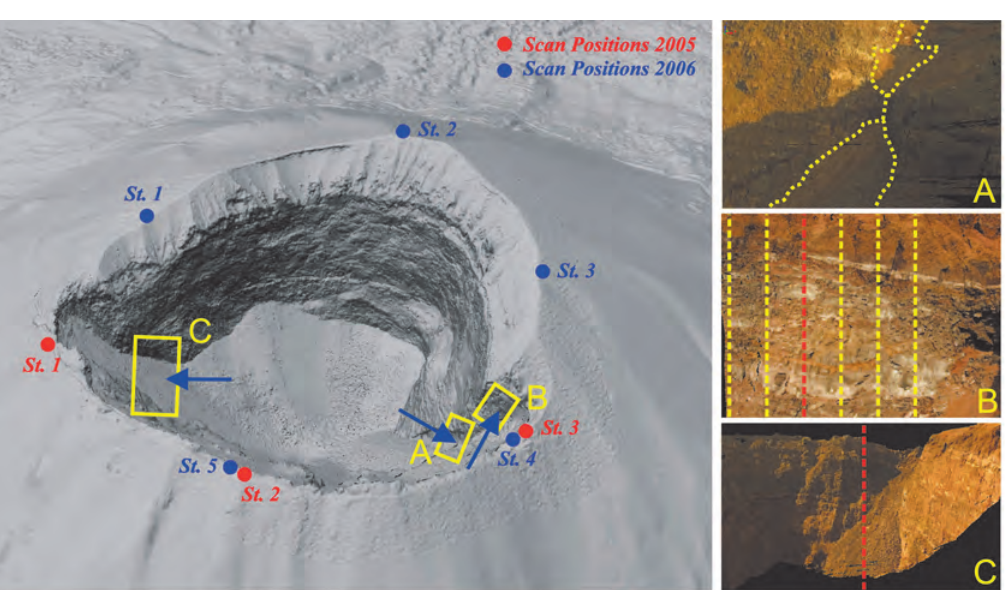
Fig. 2 . Left panel: perspective view of the Vesuvius crater. The TLS viewpoints are marked by red and blue dots, concerning 2005 and 2006 surveys respectively. Lines-of-sight are reported as arrows. Right panel: front view of the three studied outcrops (yellow boxes A, B, and C in the left panel) and vertical sections used for pre- liminary data analysis (see later